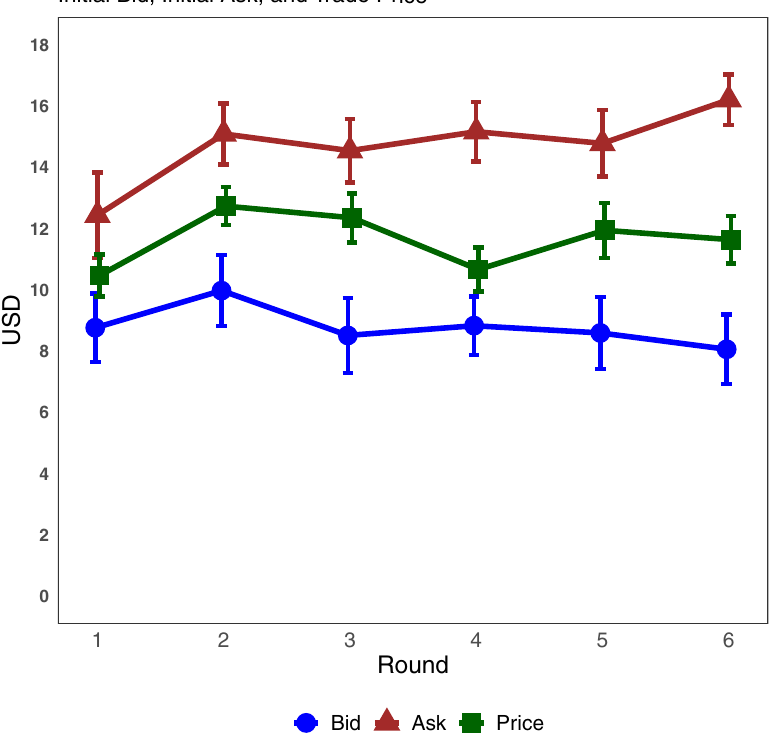
Figure 5. Average initial Bid, initial ask, and trade price per round. Vertical lines indicate standard errors.